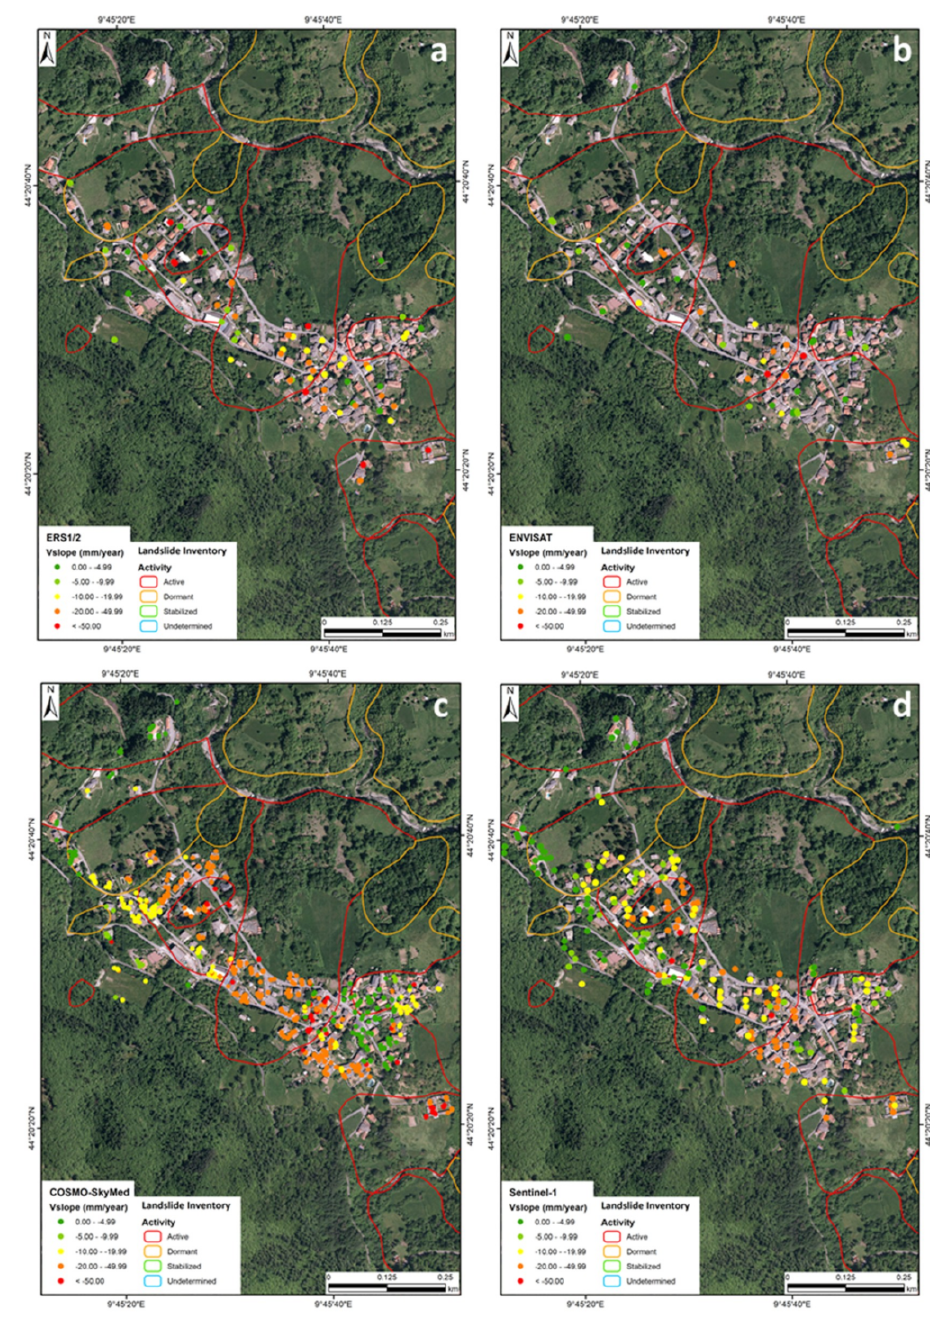
Figure 6. ERS1 / 2 ( a ), ENVISAT ( b ), COSMO-SkyMed ( c ) and Sentinel-1 ( d ) deformation map of velocity along the maximum slope for